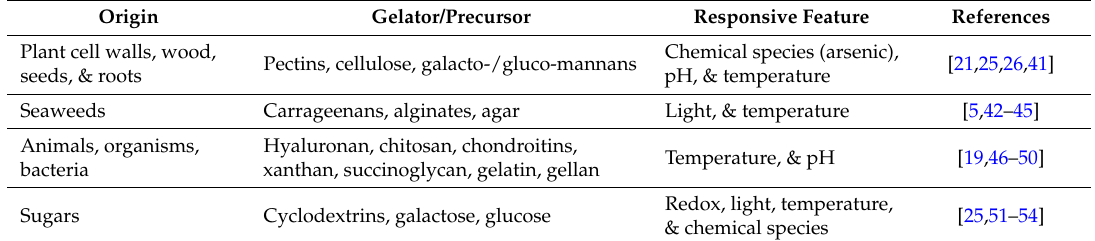
Table 1. Selected examples of polysaccharide biopolymers reported for the preparation of